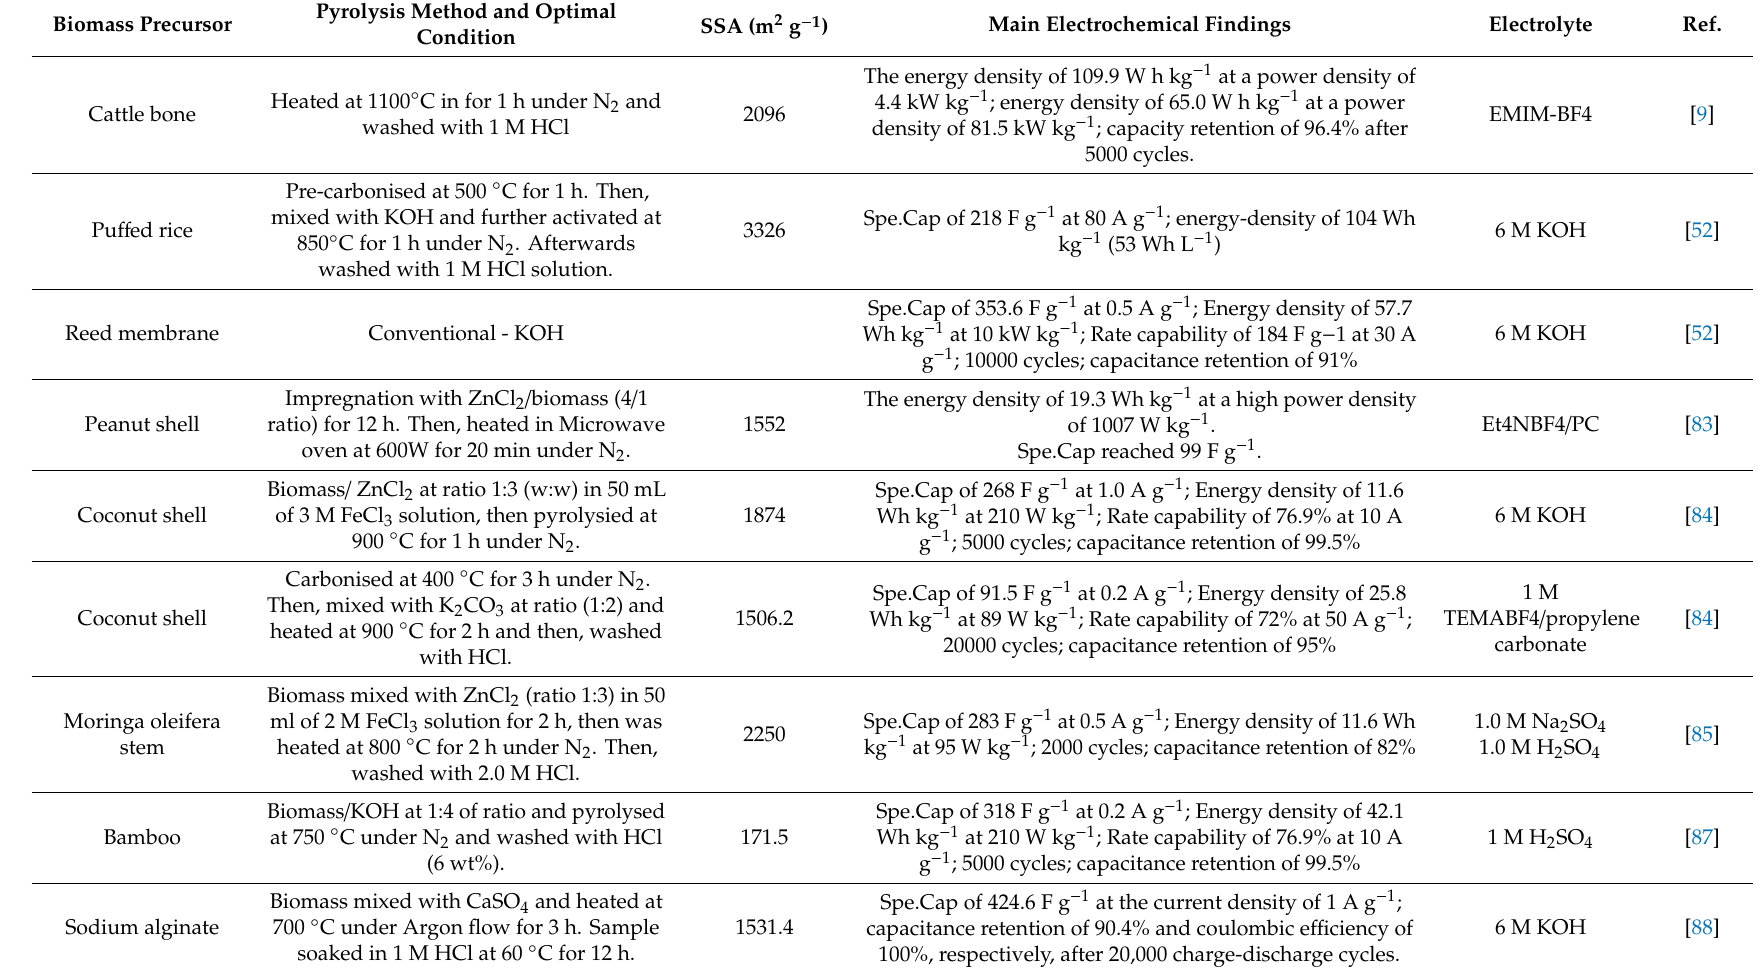
Table 3. Electrochemical performance of some biomass CEs for double-layer